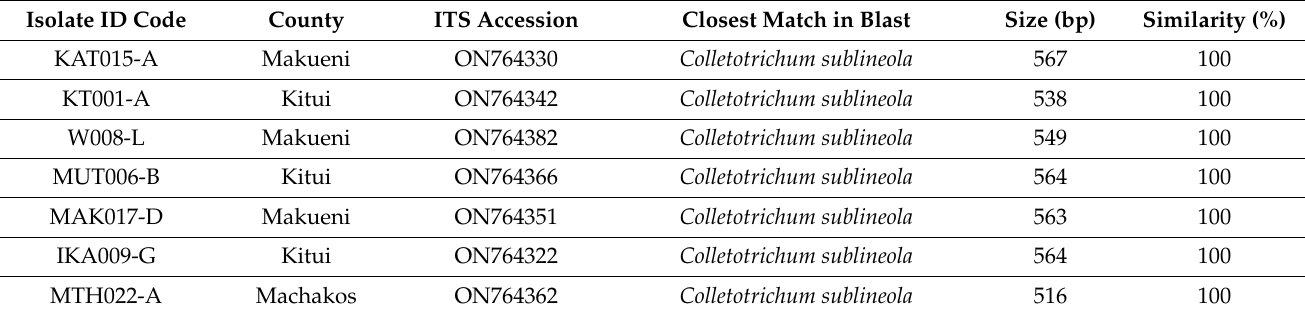
Table 4. Similarity of ITS sequences of Colletotrichum species isolated from sorghum plants with anthracnose disease in Kenya, compared with that of the accessions in the GenBank database.